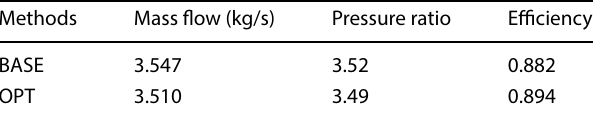
Table 5 Three-dimensional numerical results